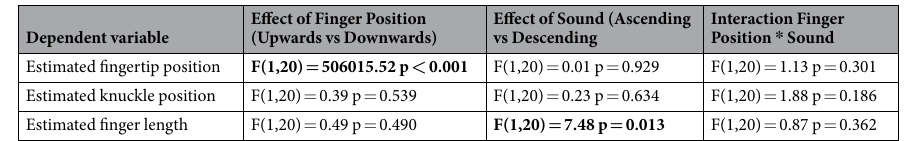
Table 3. Results from statistical tests on estimates of fingertip position, knuckle position and finger length in Experiment 2. Results from ANOVAs comparing the effects of finger position and sound are, respectively, in the second and the third column, while the interaction effects between finger position and sound are in the fourth column. Significant differences are marked in bold